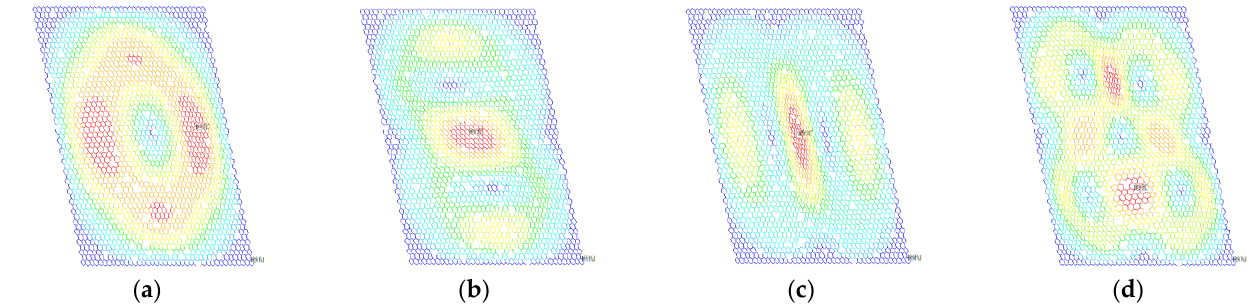
Figure 7. Rotation vector sums of porous graphene ( a – d ) for the first- to fourth-order vibration modes, respectively; the percentage of atomic vacancy defects is 1.5%.